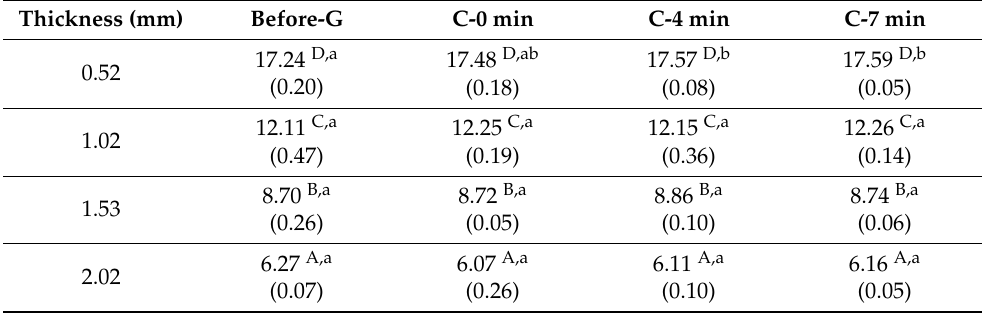
Table 6. TP as a function of cooling rate for specimens with various thicknesses (mean ± SD).